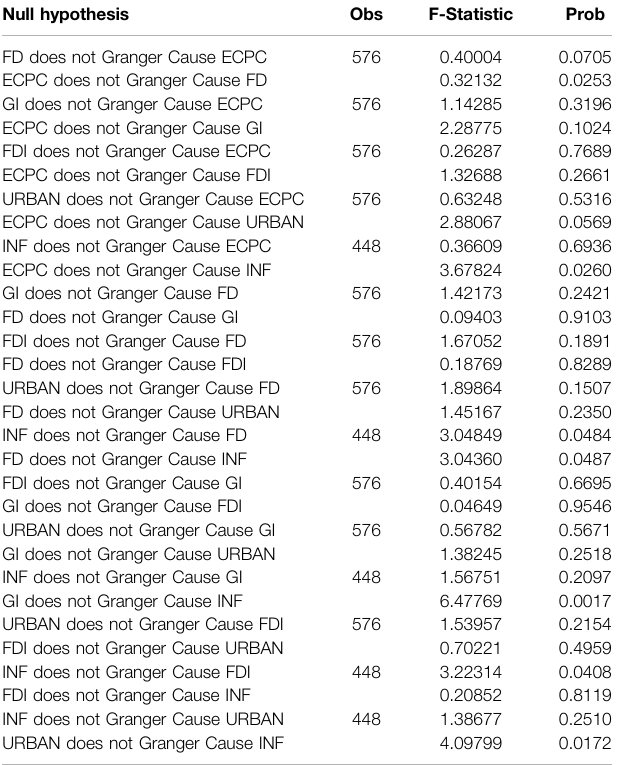
TABLE 8 | Results of the Granger Causality